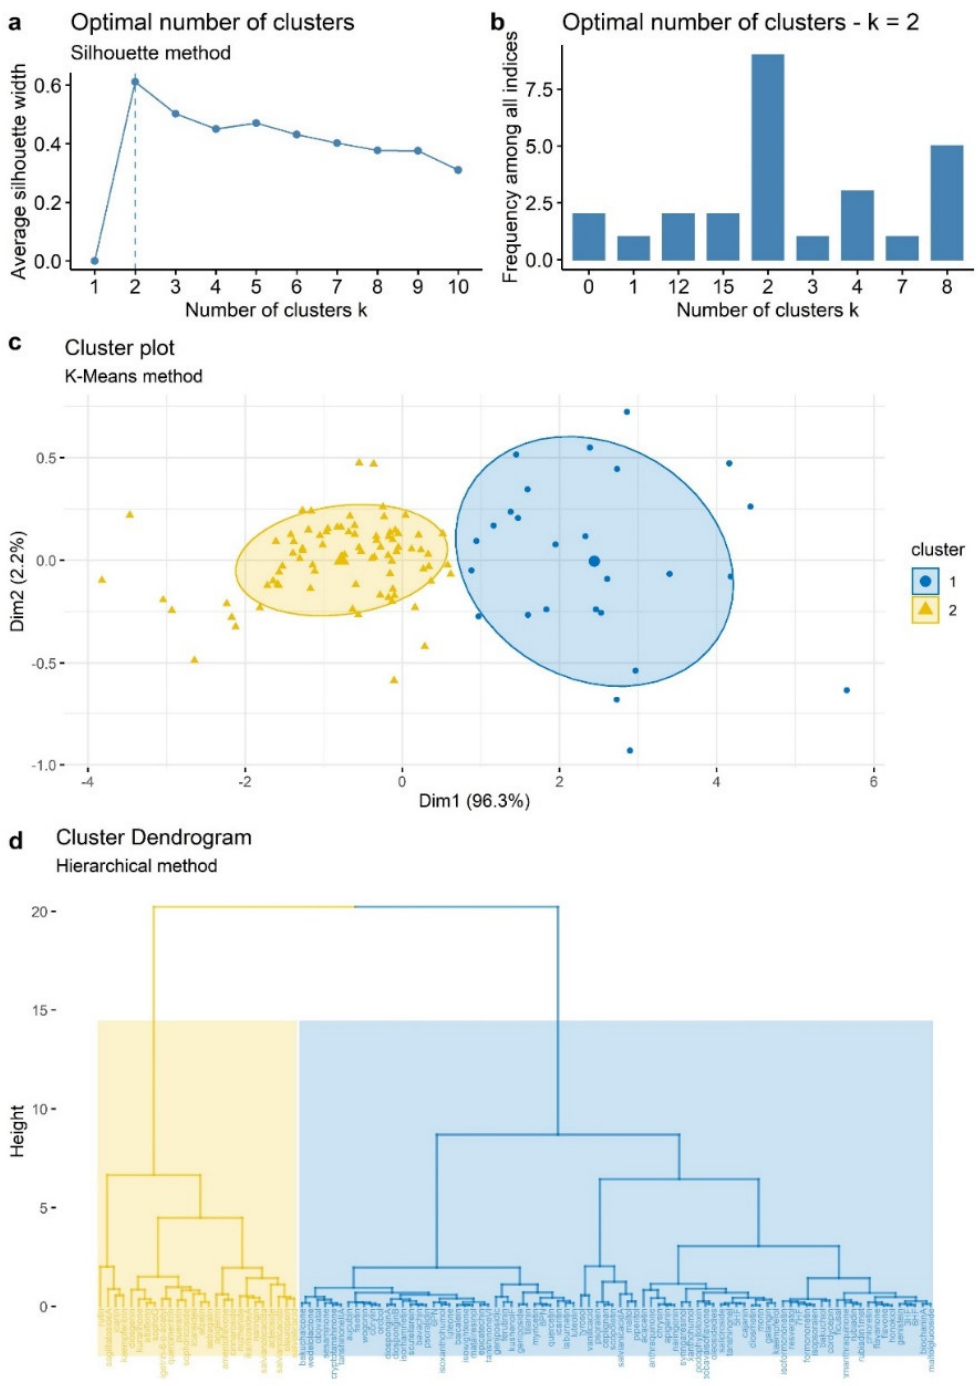
Figure 4. Clustering analysis of docking results. The numbers of clusters are identified using ( a ) average silhouette width and ( b ) frequency among all indices. The clustering shows two groups, indicating Cluster 1 (blue) and Cluster 2 (yellow). The groups of clusters are visualized in the ( c ) cluster plot generated by the K-means clustering method, and ( d ) a dendrogram generated by the hierarchical clustering method.